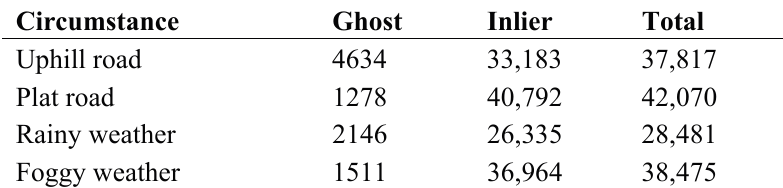
Table 3. The number of ghosts, inliers, total measurement.